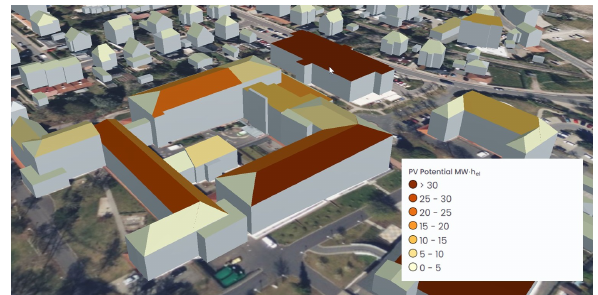
Figure 1. The simulated roof-top solar energy potential of the 3D building models in the area of Ilm-Kreis, Germany using SimStadt